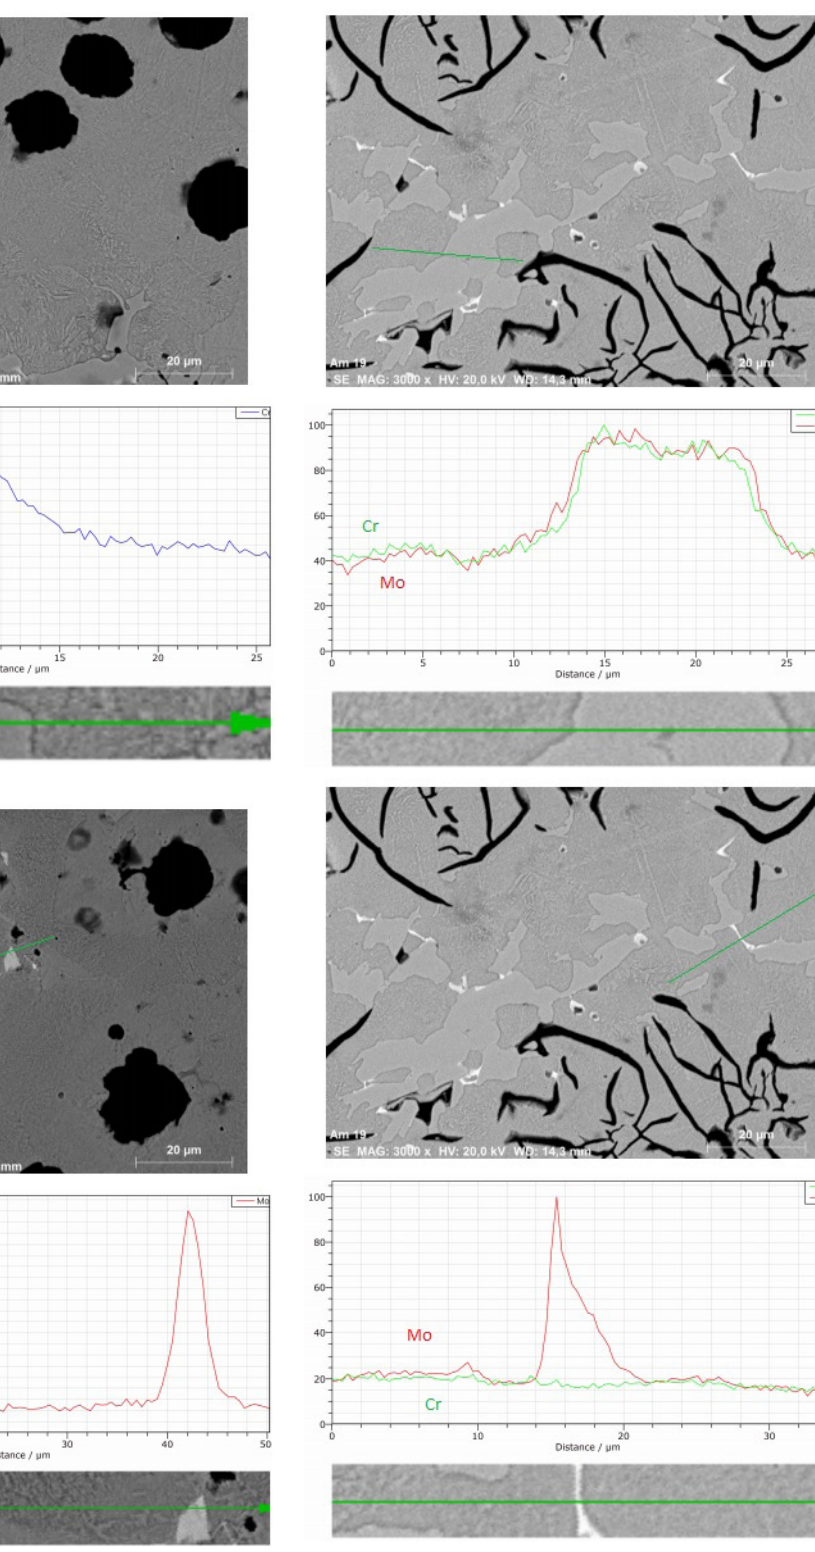
Figure 27. Mo EDS profile. Figure 28. Cr/Mo EDS profile